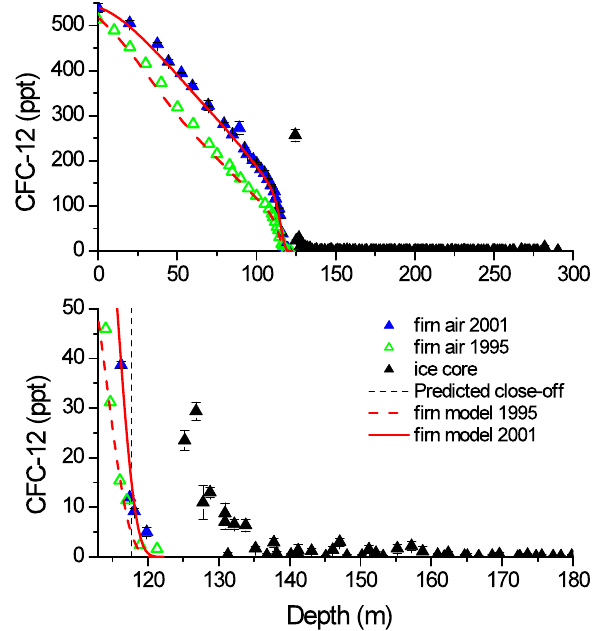
Fig. 3. Both panels – NOAA firn air data from the 1995 (green triangles) and the 2001 (blue triangles) firn campaigns at South Pole, and UCI ice core data (black triangles) from the SPRESSO site. The solid and dashed red lines are the CFC-12 profiles generated by the firn model for the 1995 and the 2001 firn samplings, respectively. In the lower panel, the scales of x- and y-axes are adjusted to focus in on the firn-ice transition. The dashed line represents the full firn close-off depth as estimated by equation (1).